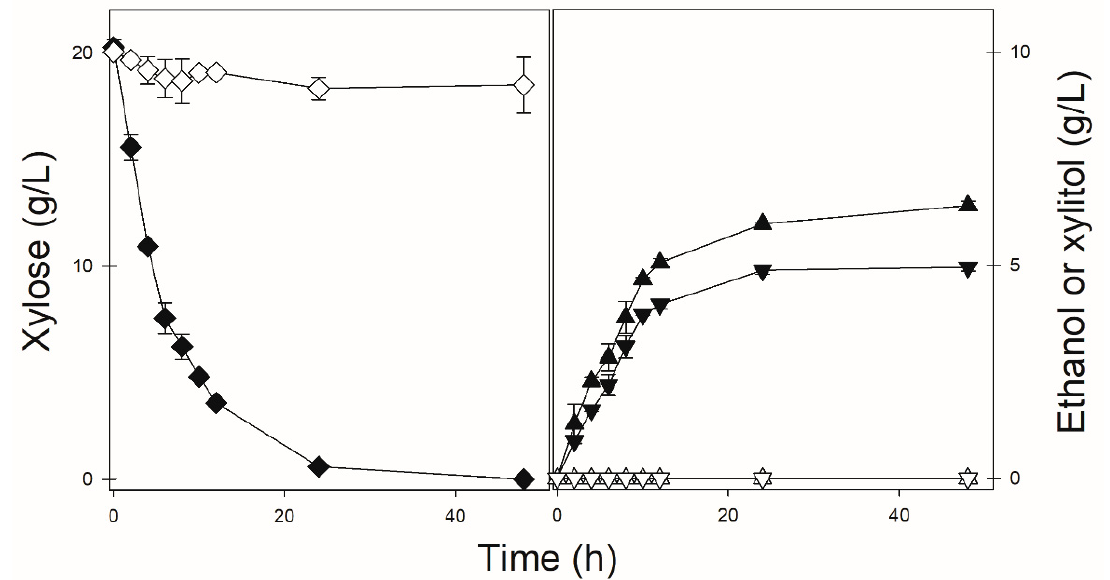
Figure 5. Xylose fermentation under microaerobic conditions by the DLG-K1 strain transformed with the pPGK- SpXUT1 (open symbols) or pPGK- SpXUT1 ∆ C (black symbols) plasmids. The batch fermentation was performed with high cell concentrations (10 g DCW/L), at 30 ◦ C, and the amount of xylose (diamonds), ethanol (tringles) and xylitol (inverted triangles) in the medium was determined at the indicated time points.